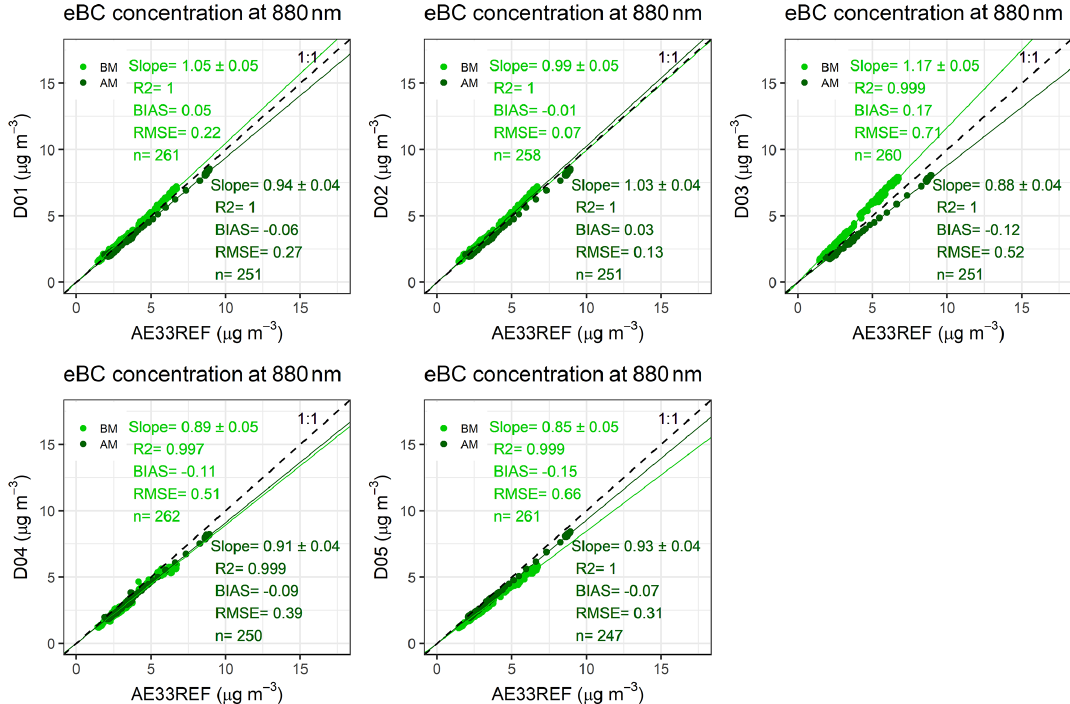
Figure 10. Regression for the comparison of the instruments in group D and the reference Aethalometer before and after maintenance during nigrosin measurements. The intercept was forced through zero. BM: before maintenance. AM: after maintenance.